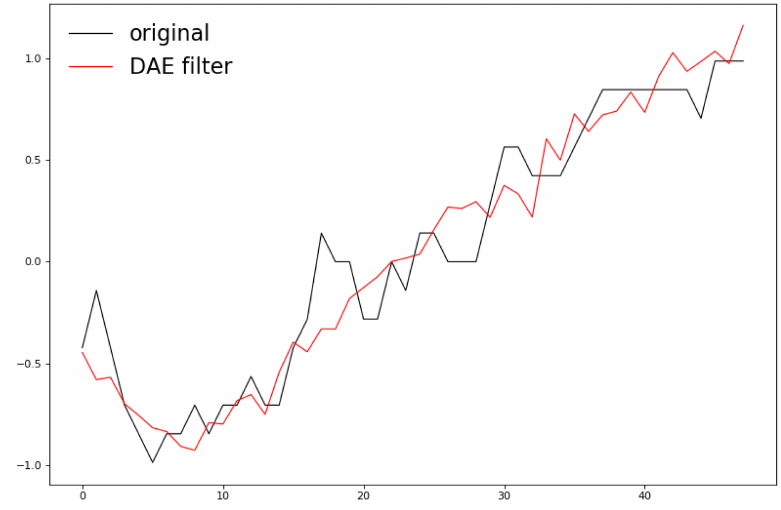
Figure 7. Example of the DAE-based